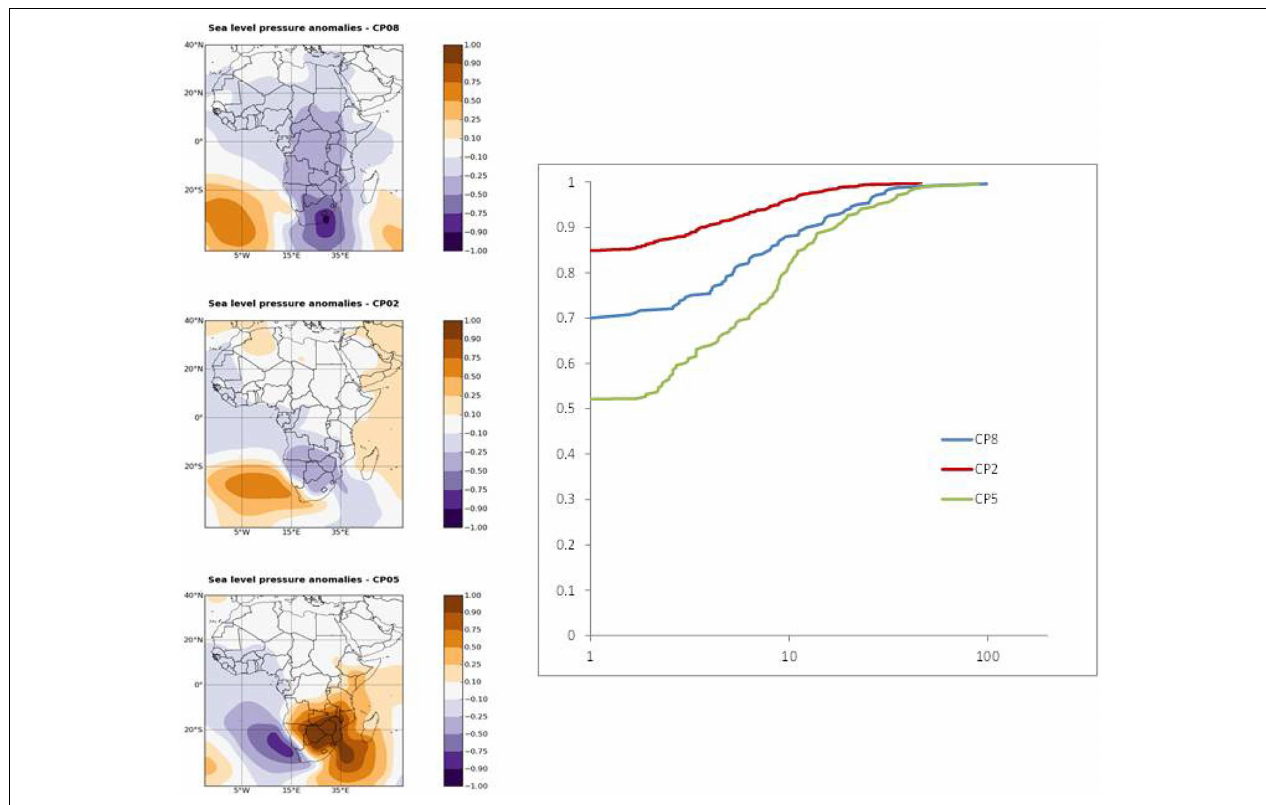
FIGURE 2 | Three different CPs and the related distributions of daily precipitation in Mpumalanga in Region 5 of Figure 1. The maps on the left are CPs 8, 2, and 5, appearing as blue (middle), red (dry), and green (wet) lines in the figure of frequency distributions.